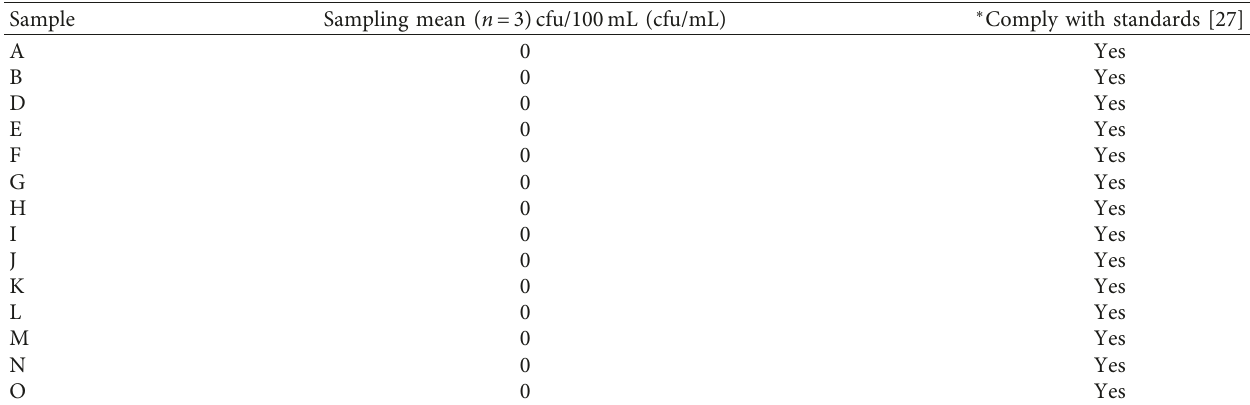
Table 4: Escherichia coli total for 15 samples of treated drinking